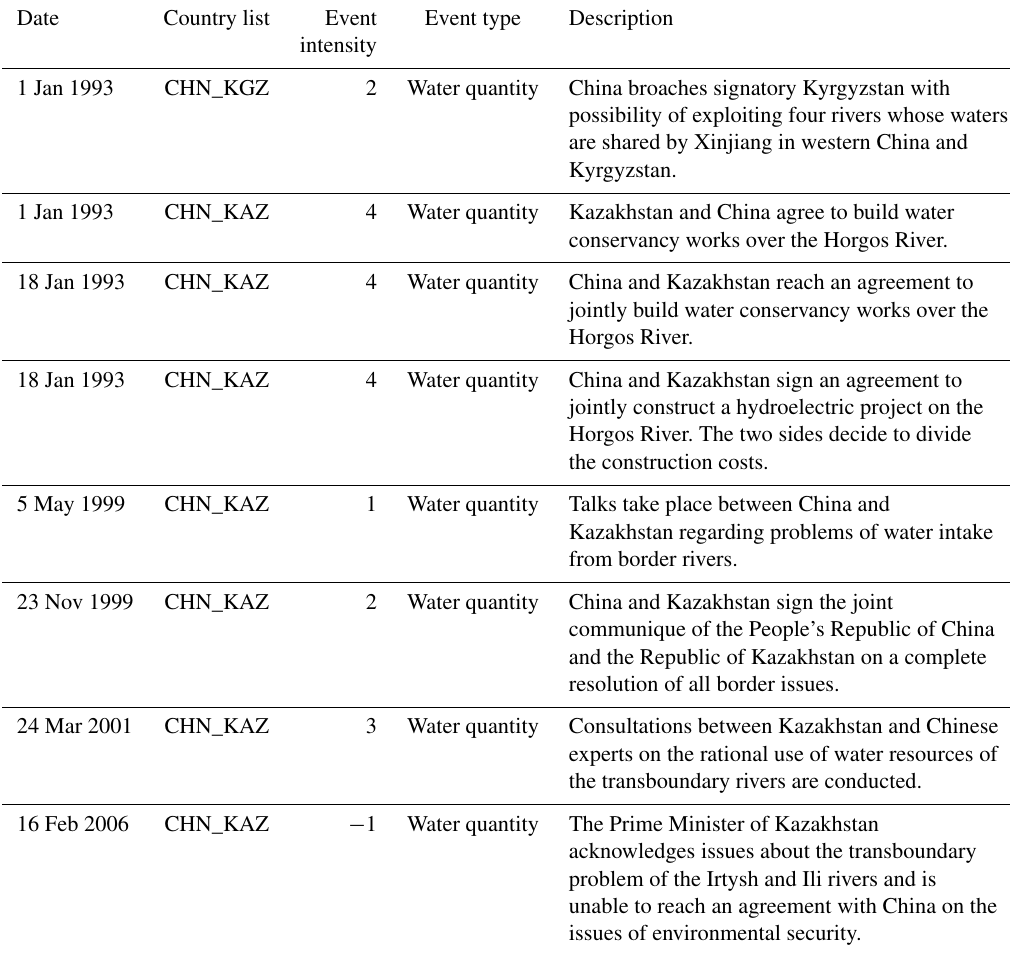
Table 5. Water-related political events in the Ili River basin between China and Central Asian